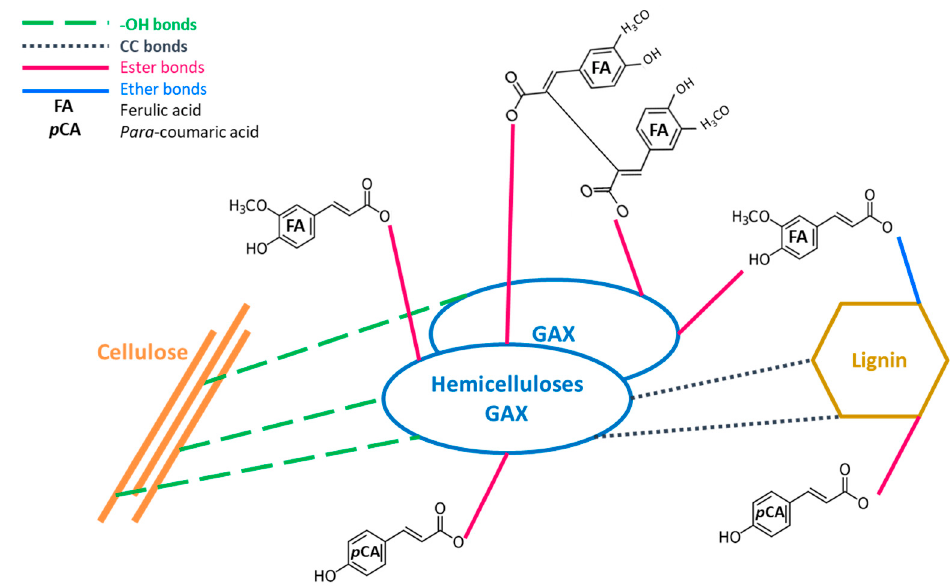
Figure 1. Global organization of grass cell wall.